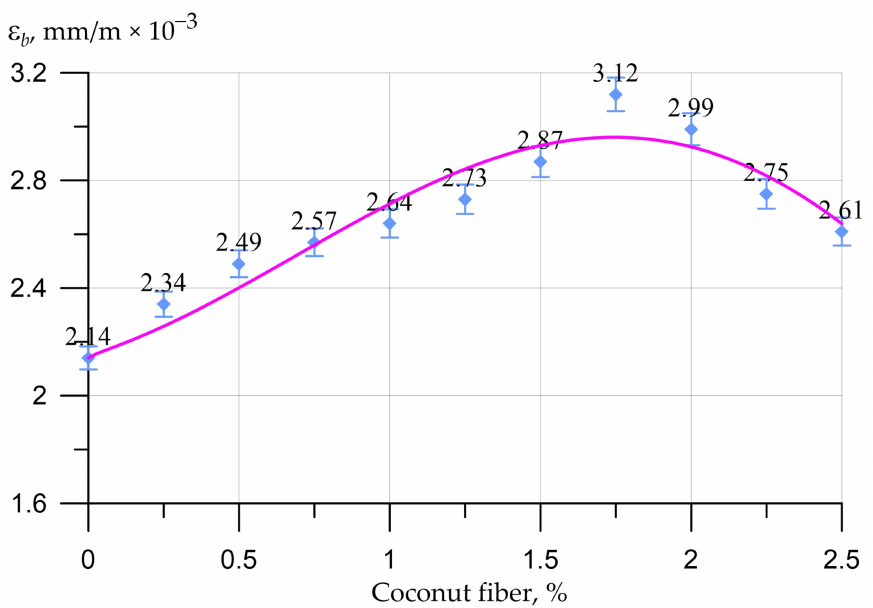
Figure 11. Dependence of the limiting deformations in axial compression ( ε b ) of prism concrete samples with dimensions of 100 × 100 × 400 (mm) on the percentage of dispersed reinforcement with coconut fibers.